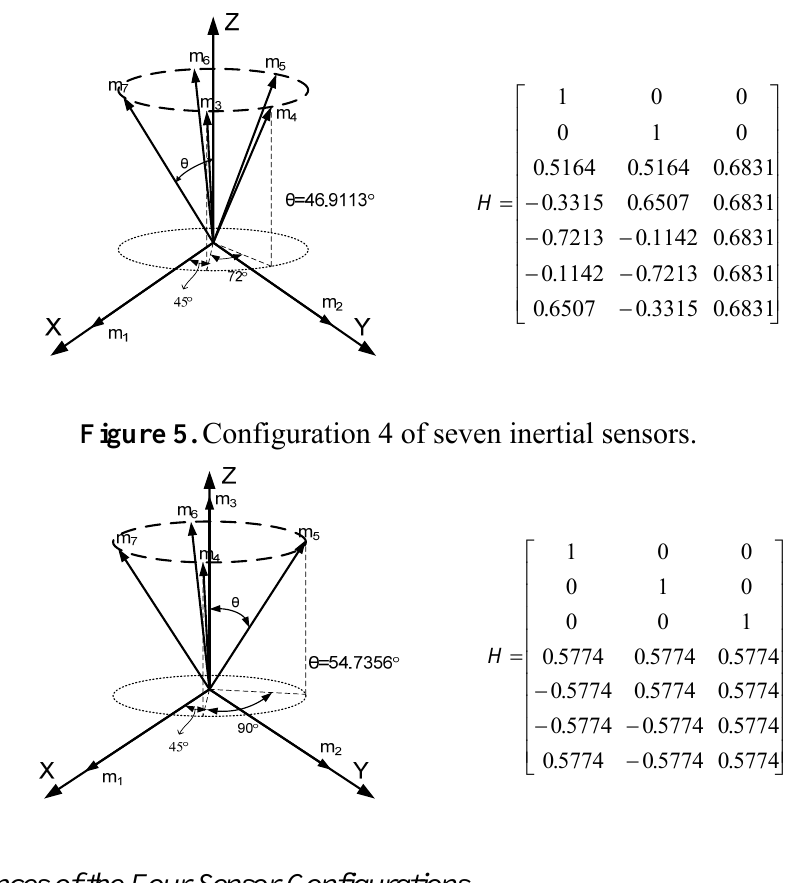
Figure 4. Configuration 3 of seven inertial sensors.